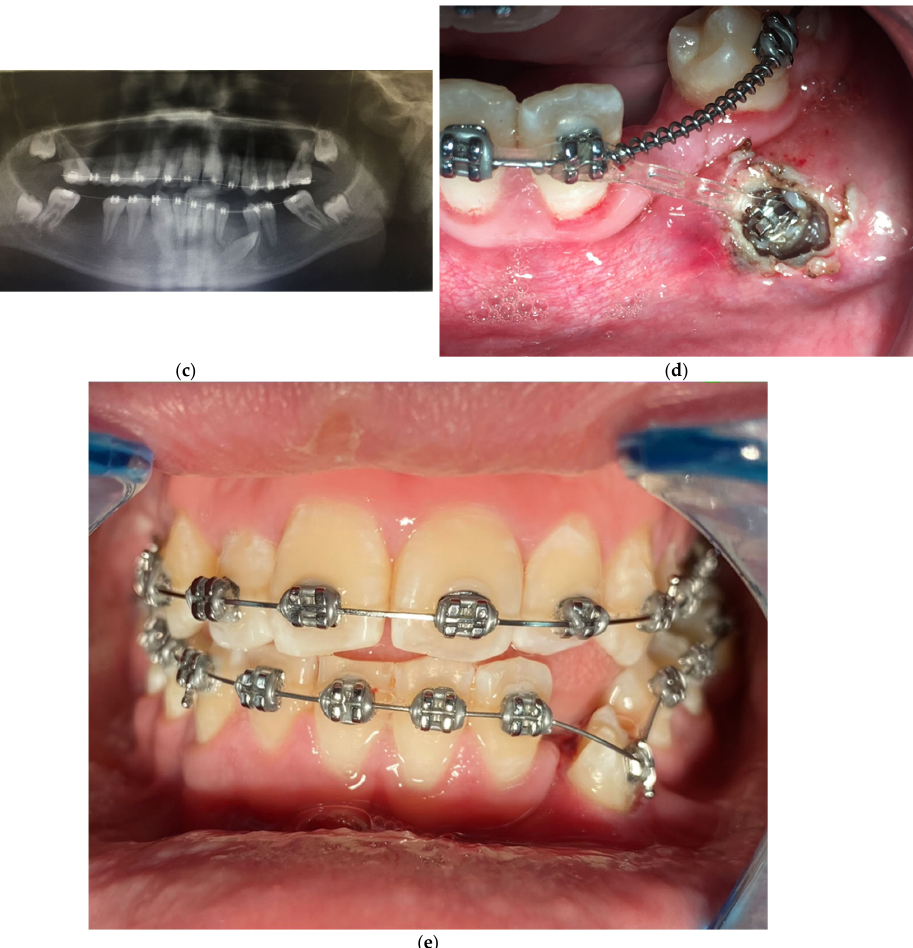
Figure 2. ( a – f ) Frontal intra ‐ oral view with a Class III malocclusion anterior cross ‐ bite, severe crowd ‐ ing in upper and lower dental arches, and impacted mandibular left canine (LL3), necessitating space opening in the area prior to laser exposure ( a , b ). In particular, the proximity to the mental nerve made the surgical exposure challenging. The preoperative panoramic view shows an im ‐ pacted LL3 after space opening in the area and 4 extracted first permanent molars ( c ). Diode laser exposure (940 nm) with immediate bonding and orthodontic traction is demonstrated ( d ). Subse ‐ quent to further eruption (after about 5 months), the LL3 was rebonded with a canine bracket ( e ). Frontal view showing substantial correction of the Class III incisors, anterior cross bite, dental centre lines, and eruption of LL3 (treatment ongoing) ( e